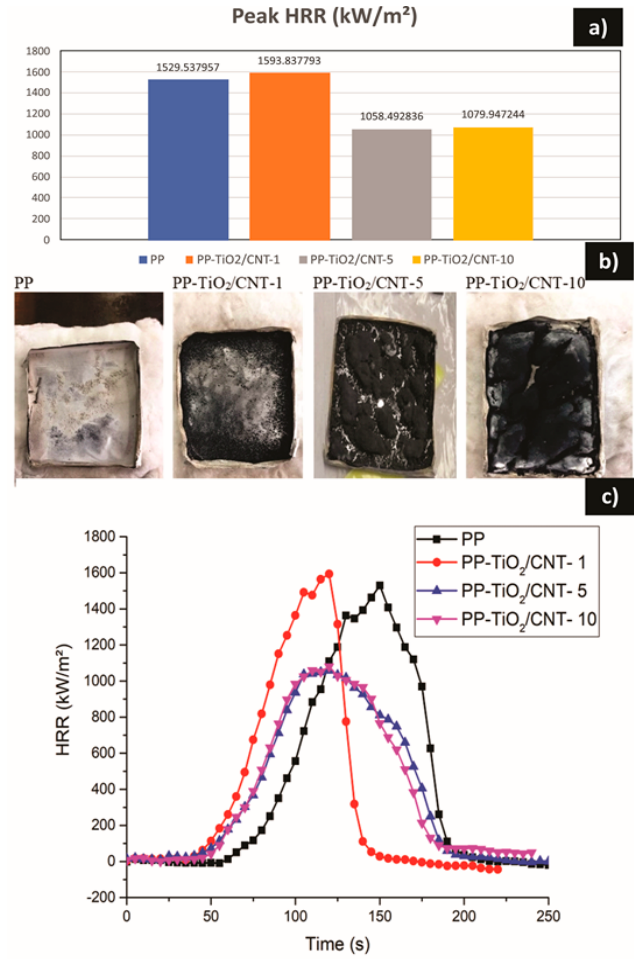
Figure 8. Calorimetric measurements ( a ) Comparison of the peaks of the heat release rate (HRR), ( b ) Photographs of residual material after the cone calorimetric test ( c ) HRR curves for the results.